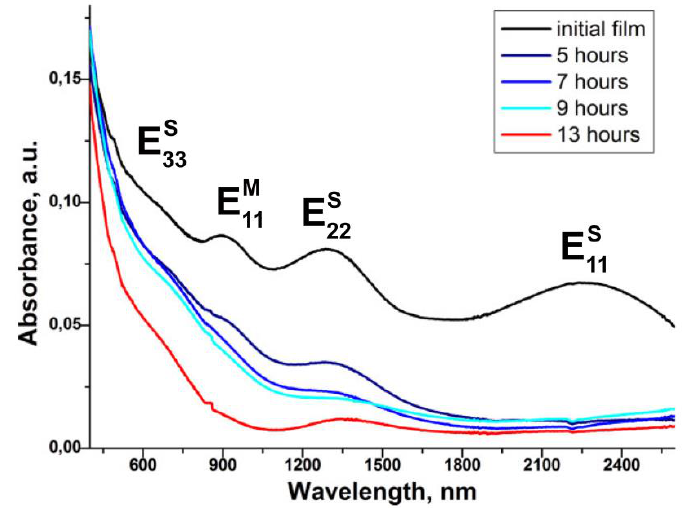
Figure 2. The OAS spectra evolution upon exposure to CuCl gas. Reprinted with permission from [129], copyright 2015 Wiley-VCH Verlag GmbH & Co. KGaA,